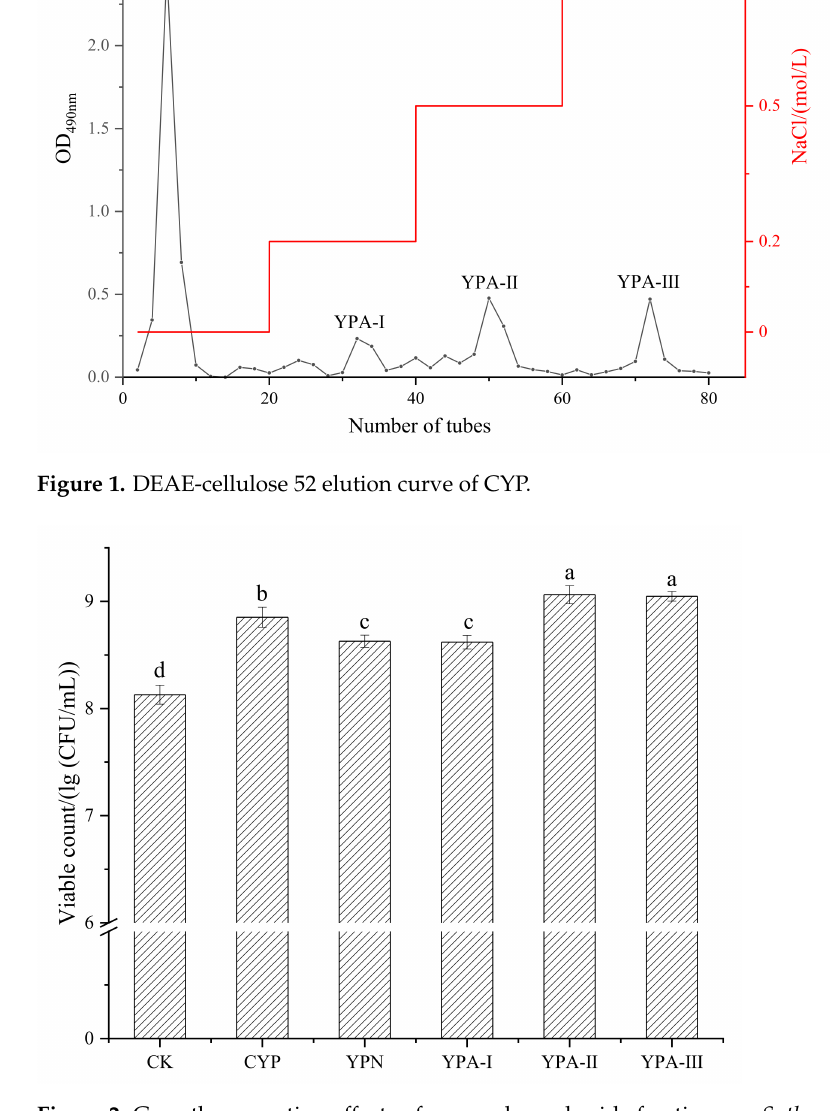
Figure 2. Growth-promoting effects of yam polysaccharide fractions on S. thermophilus . The same letters show the homogeneous